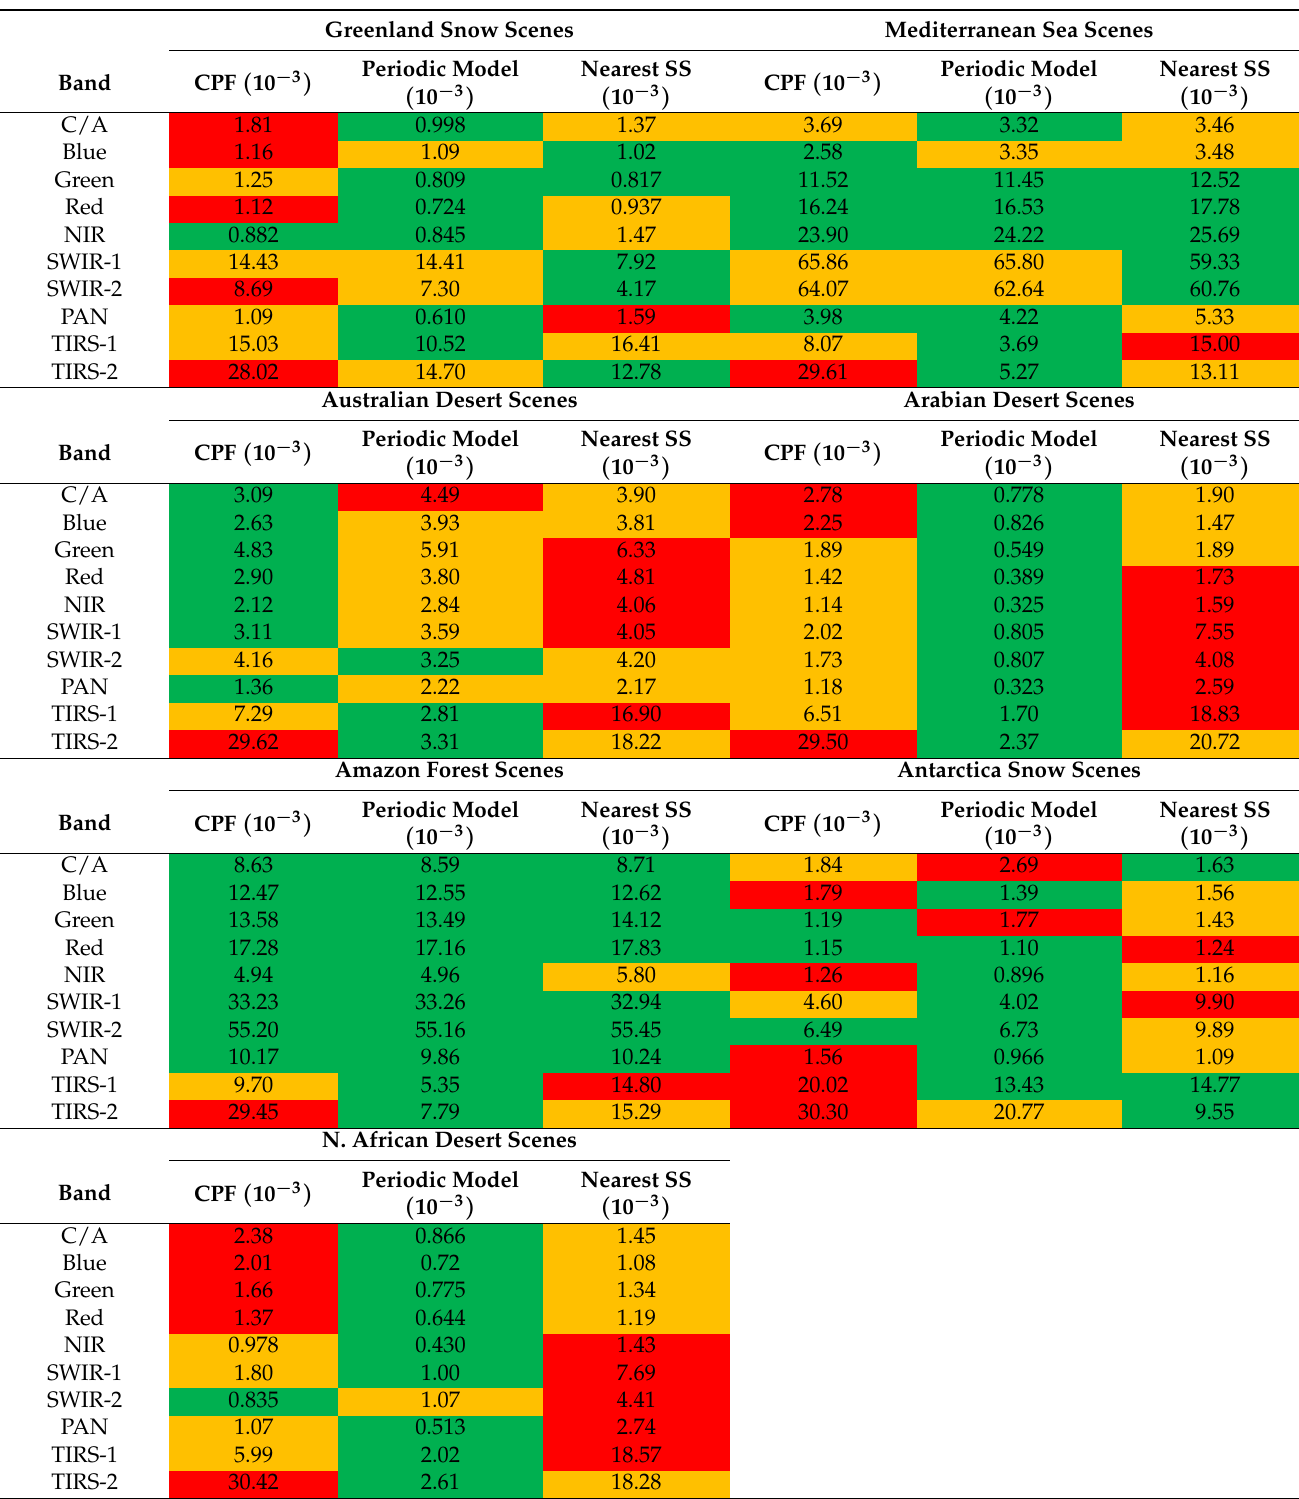
Table A3. Complete table of Overlap Detector Metric comparison; red data is statistically the worst, followed by yellow data, and green data is statistically the best; if multiple cells are the same color that data is statistically the same, as proven by the t